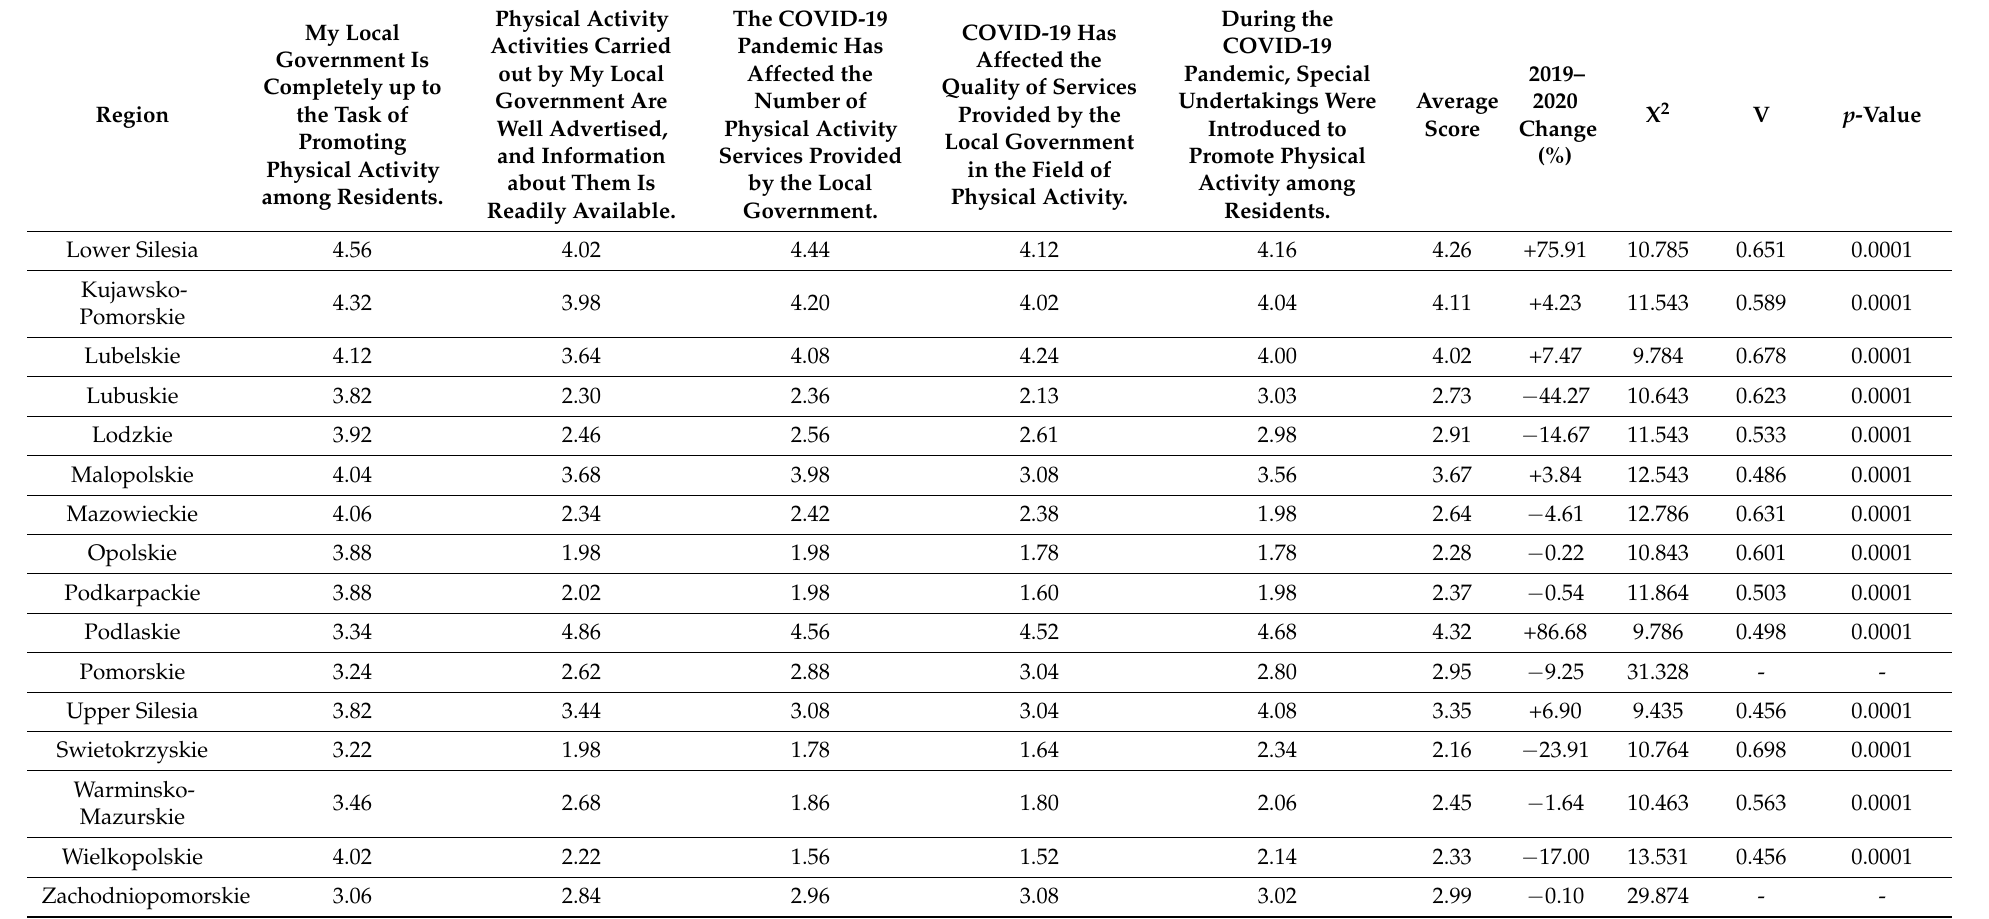
Table 3. Relationship between the opinion on the realized activity of local governments in physical activity and the difference in spending for this purpose in the years before and during the COVID-19 pandemic ( n =